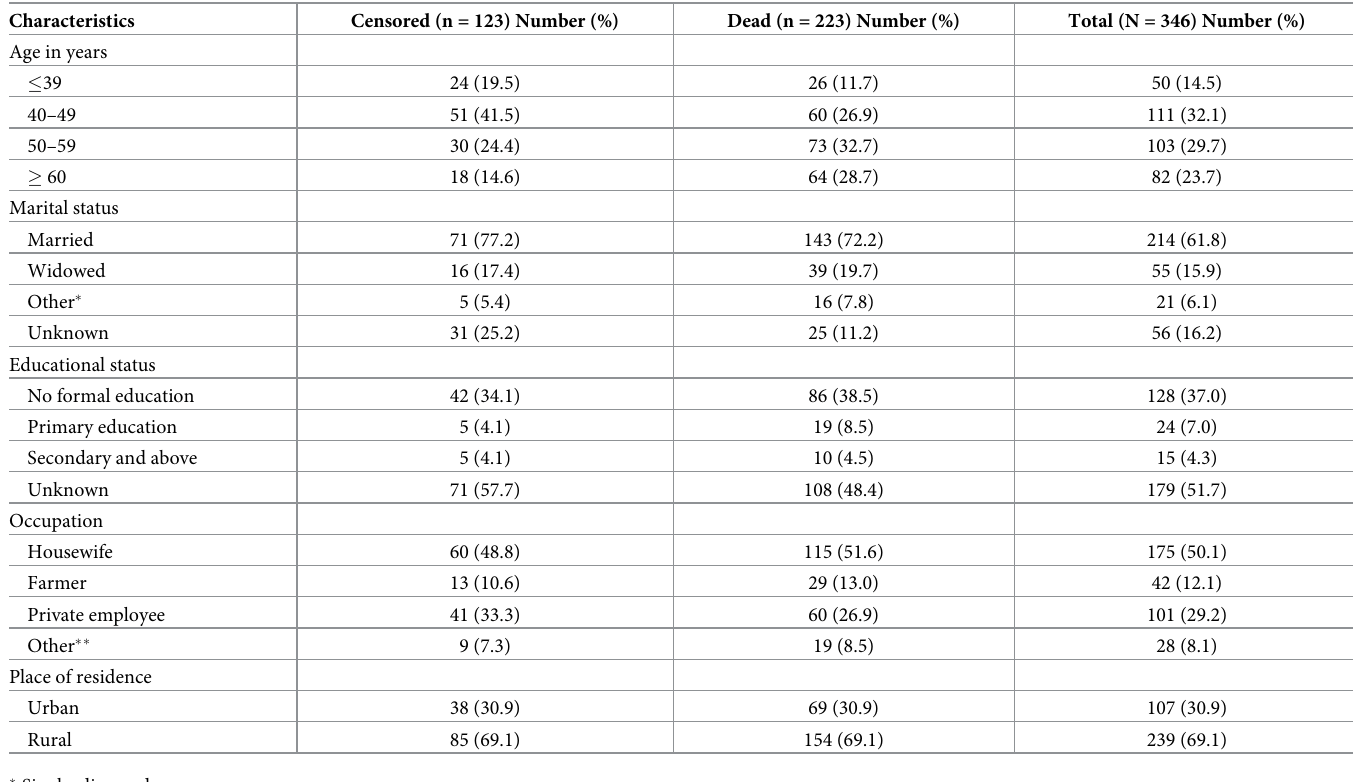
Table 1. Socio-demographic characteristics of CCP in TASH from July 2014 –July